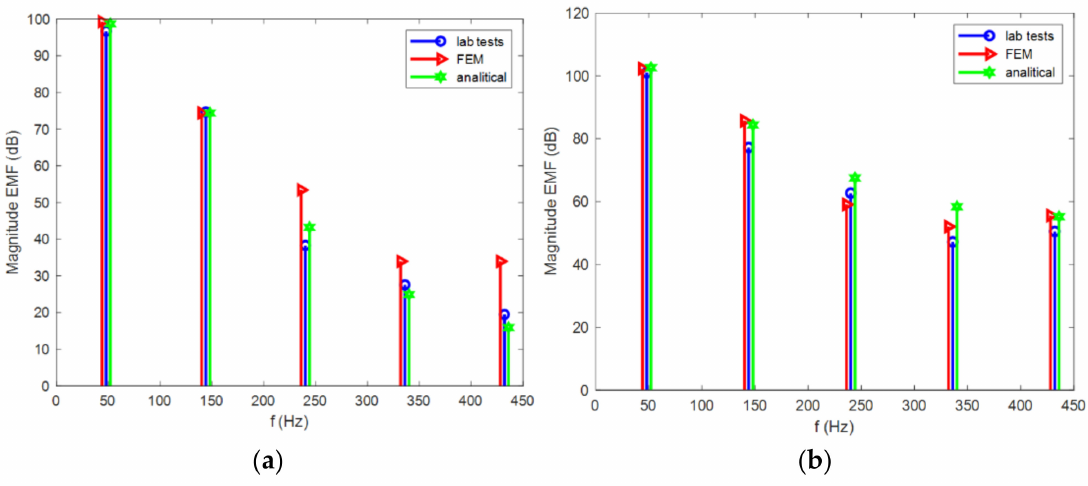
Figure 8. FFT spectrum of EMF ( a ) AFPMG—coreless stator ( b ) for AFPMG—core stator. Table 3 contains comparisons of the values of the THD EMF coefficient and the RMS values for the induced EMF of the generators, showing the relative error of calculations in relation to the measurements. Table 3. Comparison of the results obtained from analytical models and laboratory tests for EMF. THD EMF EMF (RMS) AFPMG Analytical Analytical Measure Measure | ∆ EMF (%) | Calculations Calculations (a) coreless stator 6.1% 6.5% 61.3 V 62.6 V 2.1% (b) stator with cores 6.0% 7.3% 101.3 V 95.8 V